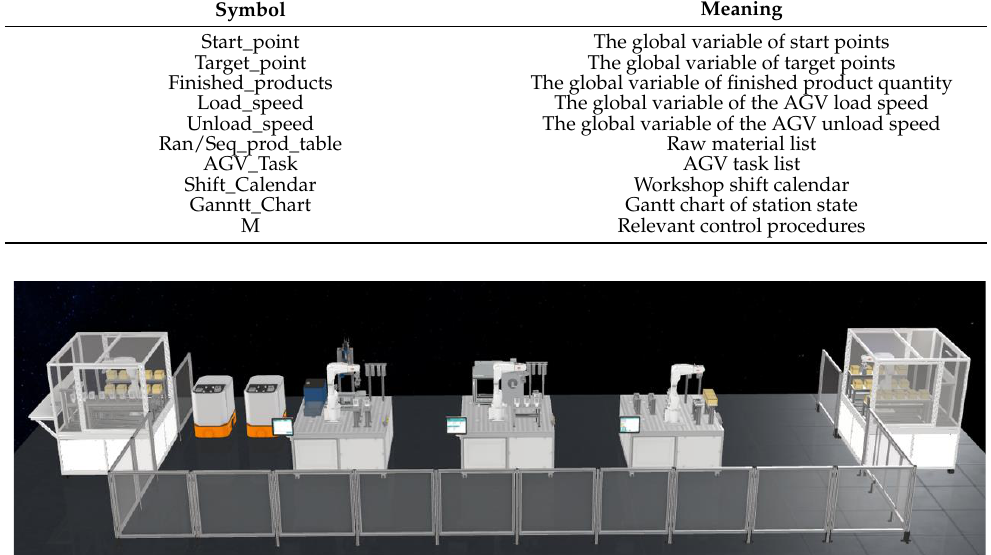
Figure 11. The virtual action model of an assembly line.